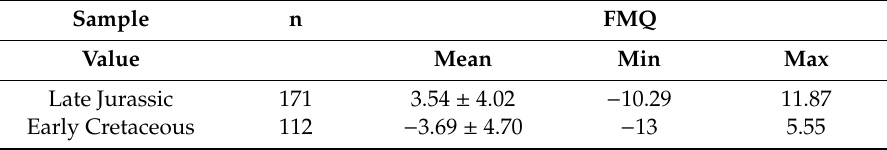
Figure 9. Log fo 2 values vs. U-Pb age plot for the Yanshanian granites in Jiangxi Province (P < 0.01 and R = 0.72). Table 4. Statistics of oxygen fugacity data for Yanshanian granites in Jiangxi